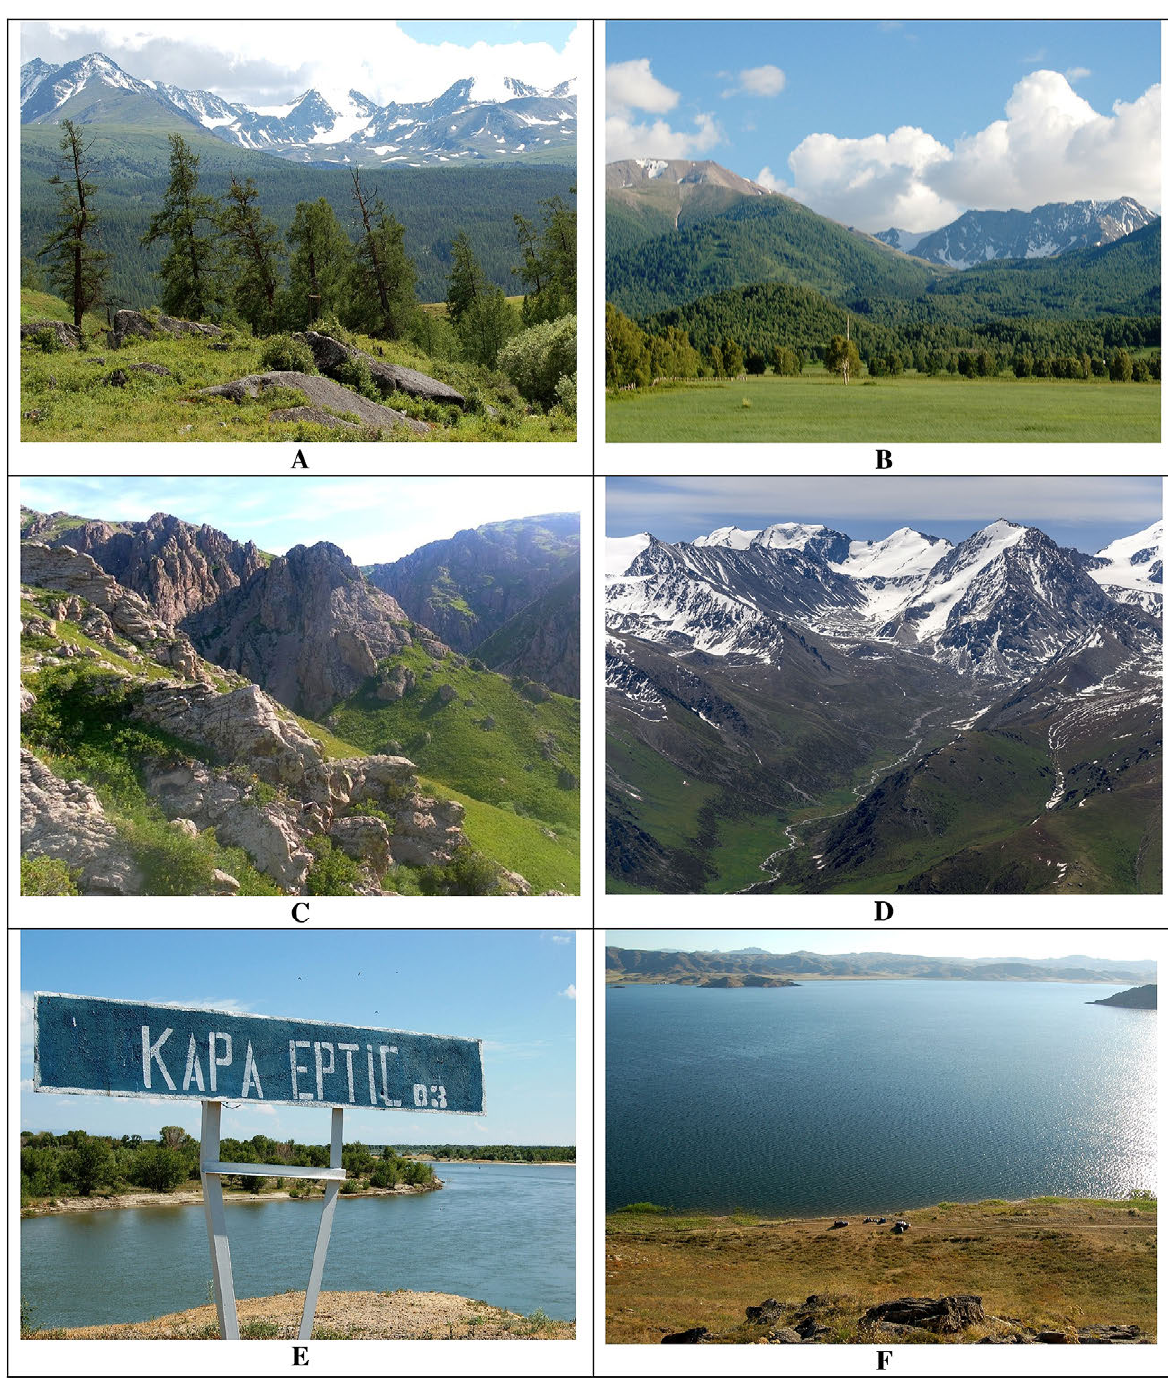
Fig. 6. Present landscape physiography associated with the discussed oronyms and hydronyms in Eastern Kazakhstan. A. Southern Altai massif (4,082 m a.s.l.) (Katon-Karagai District); B. Narym Mountains (3,816 m a.s.l.); C. Tarbagatai Mountains (2,992 m a.s.l.); D Dzungarskyi Alatau Mountains (4,622 m a.s.l.); E. Black Irtysh River (Kurchum District) draining from the Chinese Altai; F. Lake Zaisan filling a tectonic depression (water lever at 420 m a.s.l.) connecting to the Bukhtarma